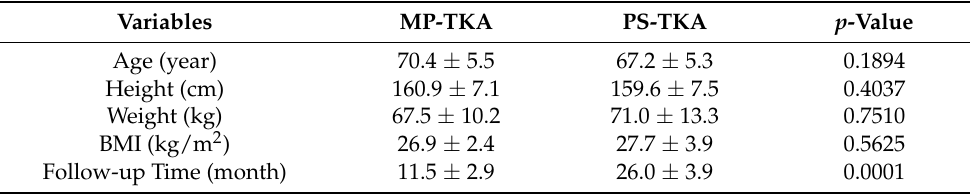
Table 1. Patient demographics